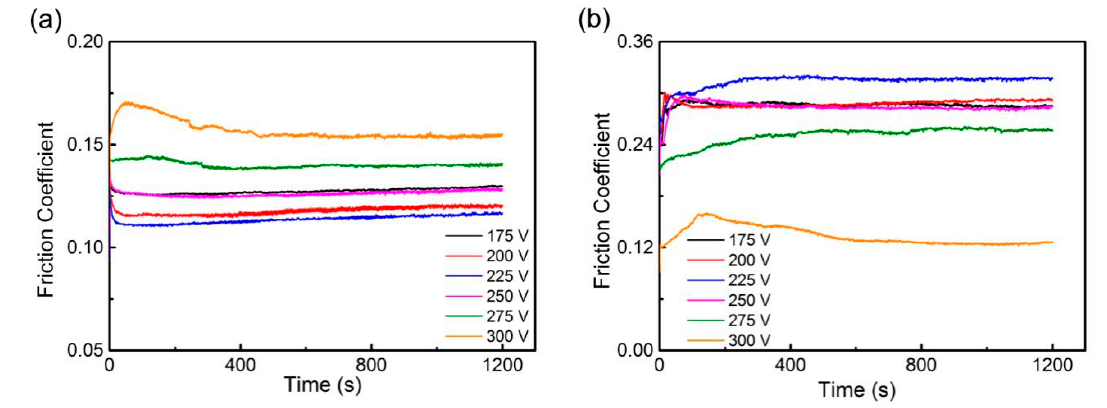
ffi cient waveforms against: ( a ) Si3N4; ( b ) Figure 6. Friction coefficient waveforms against: ( a ) Si3N4; ( b ) Ti6Al4V. Figure 6. Friction coe